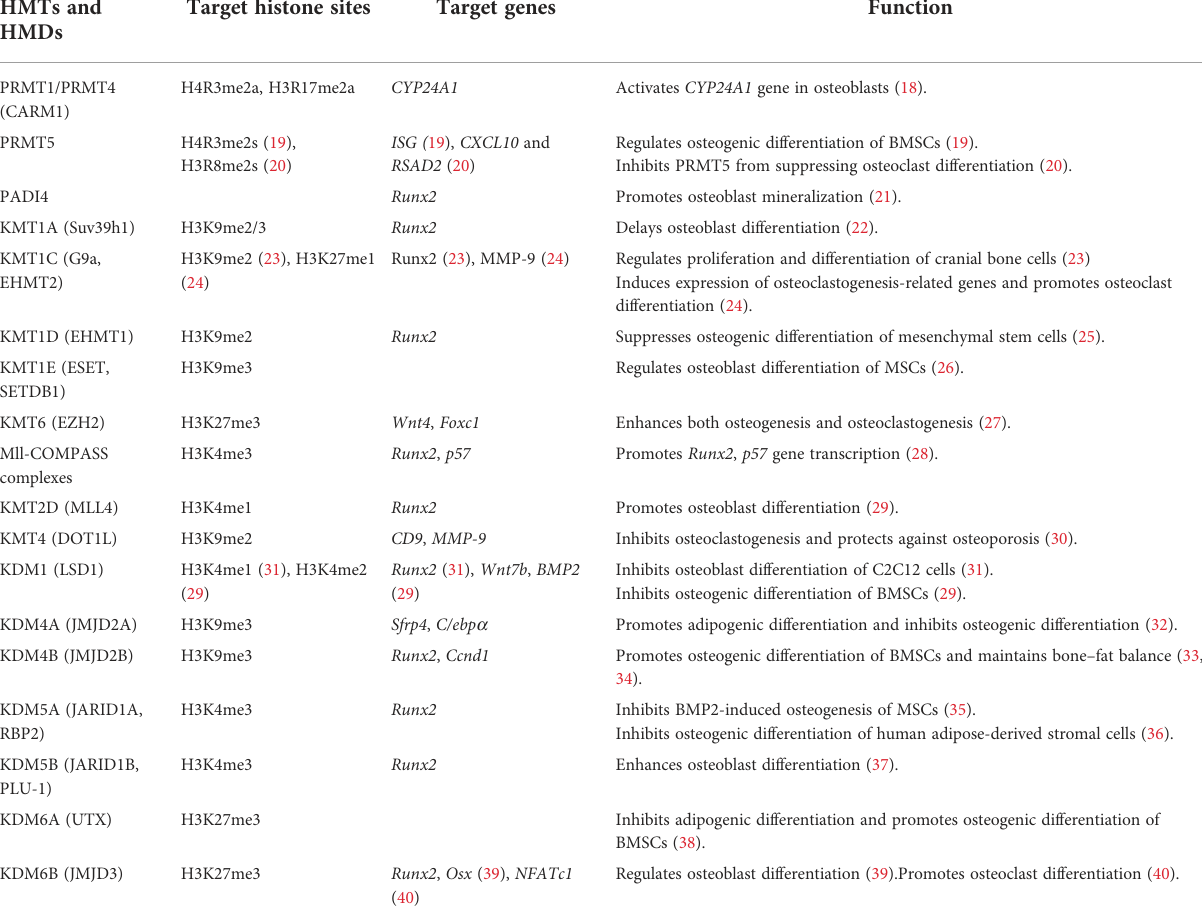
TABLE 1 Histone methyltransferases, histone demethylases, target histone sites, and their roles in the occurrence and development of osteoporosis. HMTs and Target histone HMDs